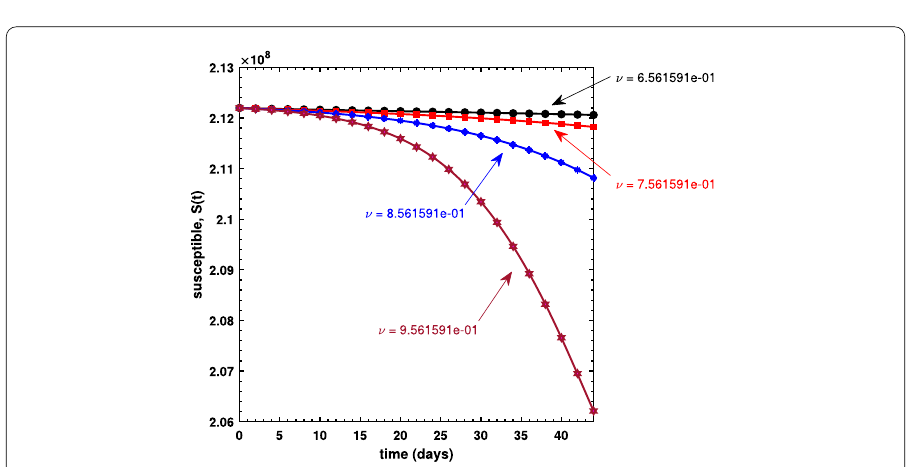
Figure 8 Behavior of the susceptible population for different values of the fractional-order parameter